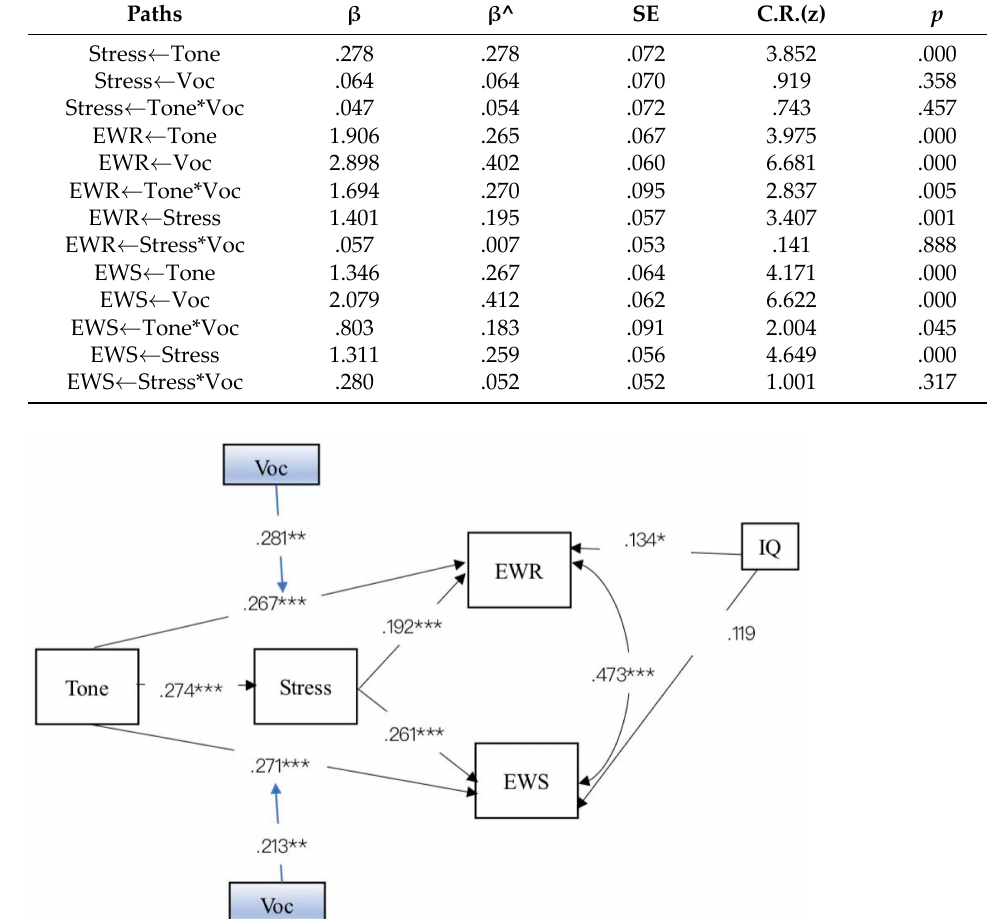
Figure 4. The respecified moderated mediation model of tone, stress, vocabulary, and English word‑ level literacy with standardized factor loadings. * p < .05, ** p < .01, *** p <